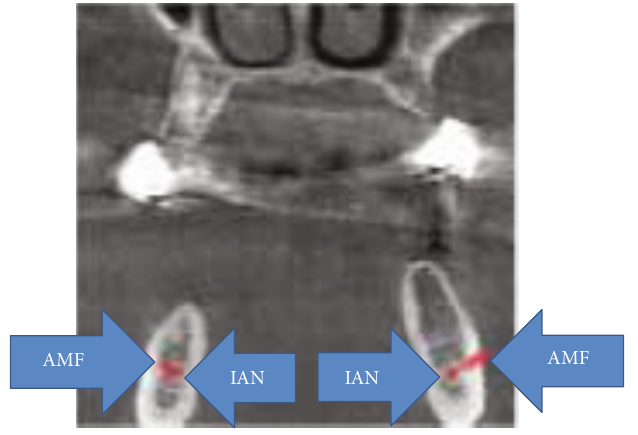
Figure 1: Right and left AMF at coronal CBCT.